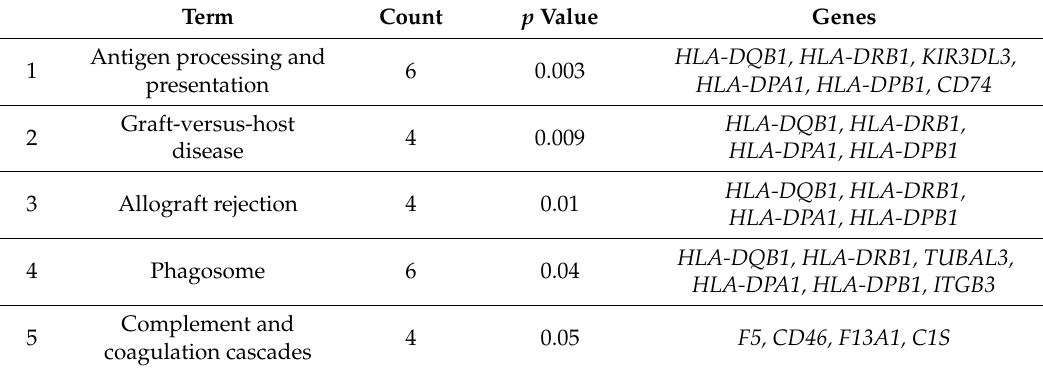
Table 6. Top five molecular pathways of di ff erentially expressed genes shared between MDA-MB-231 xenograft mice exposed to 2, 6 and 9 Gy of proton irradiation. Top 5 Molecular Pathways of Di ff erentially Expressed Genes Shared Between